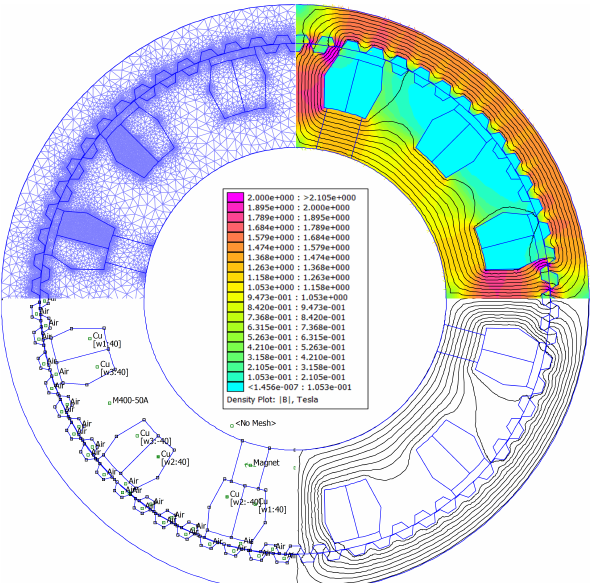
Figure 17. Optimized ORDSPMG resulted after SOS algorithm application (design/properties, FEA mesh, flux lines and flux density distribution are depicted in combined view).